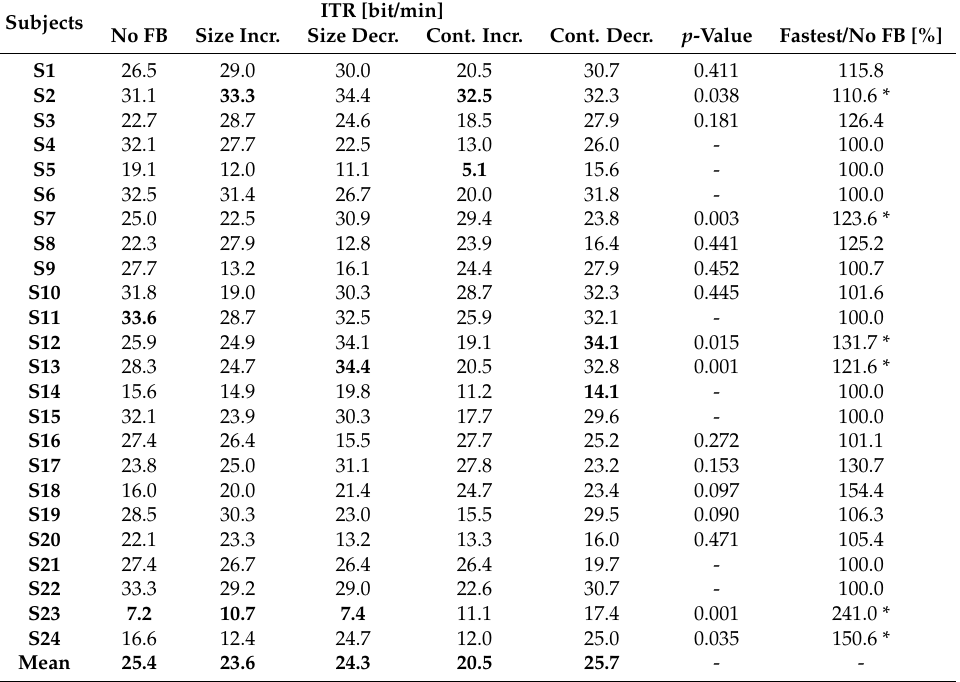
Table 2. The ITR results with the interface. S1–S24 notes the subjects, and the different columns refer to different feedback methods (as compared to the no feedback condition, shown as ‘No FB’). Lowest and highest ITRs are marked bold for each feedback method. The subject-wise ratio of the fastest method and the “ no feedback ” condition is shown with the ITR results. p -values show the significance of the subject-wise comparisons, described in Section 3.1. Significant differences are marked with an ‘*’. Subjects Size